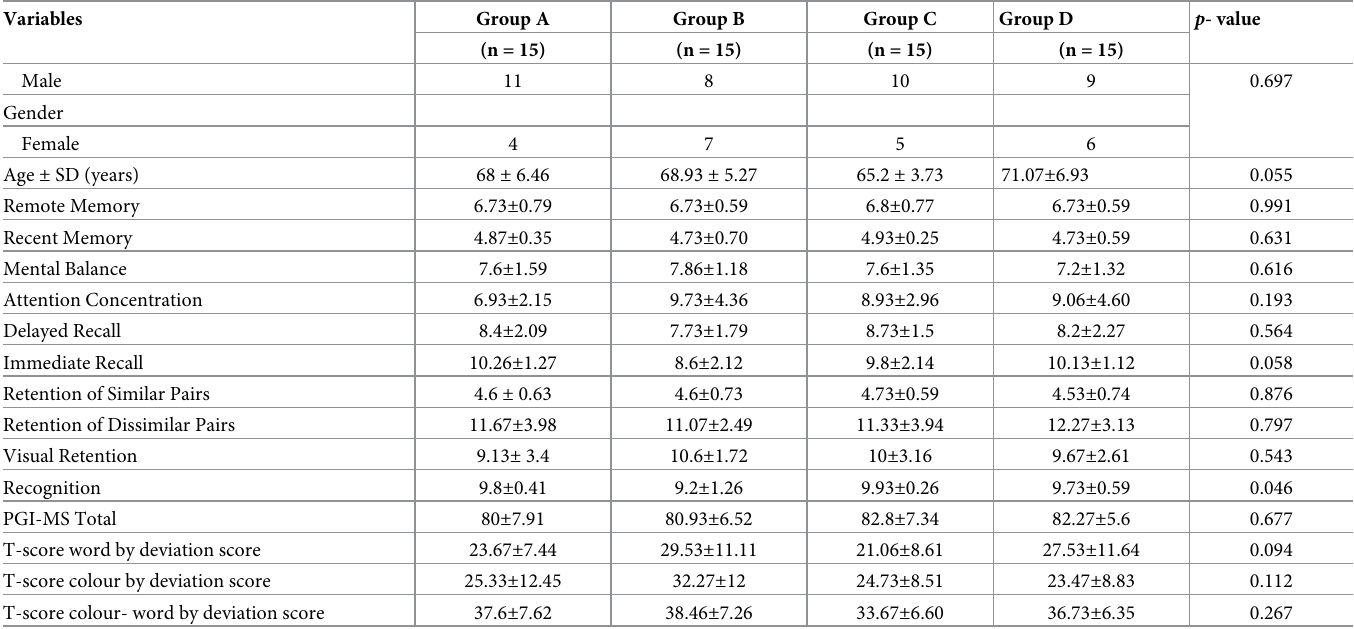
Table 1. Baseline characteristics of the study participants.